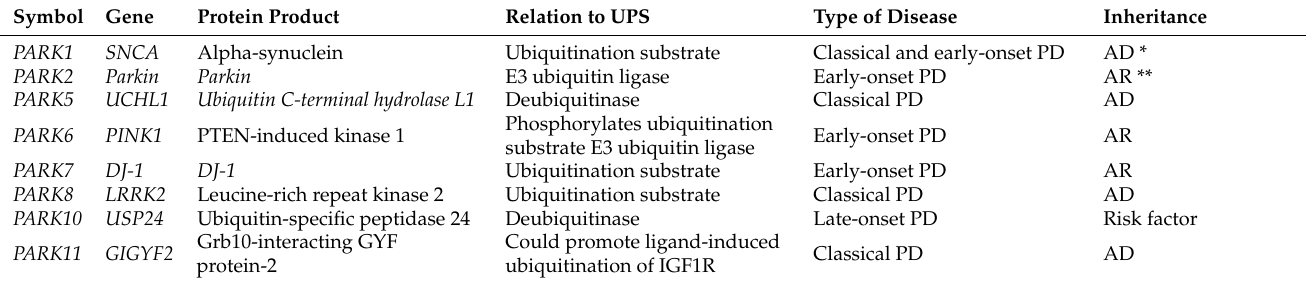
Table 1. Some PARK-designated genes and their protein products involved in inherited forms of Parkinson’s disease (modified from [30,31] and supplemented).